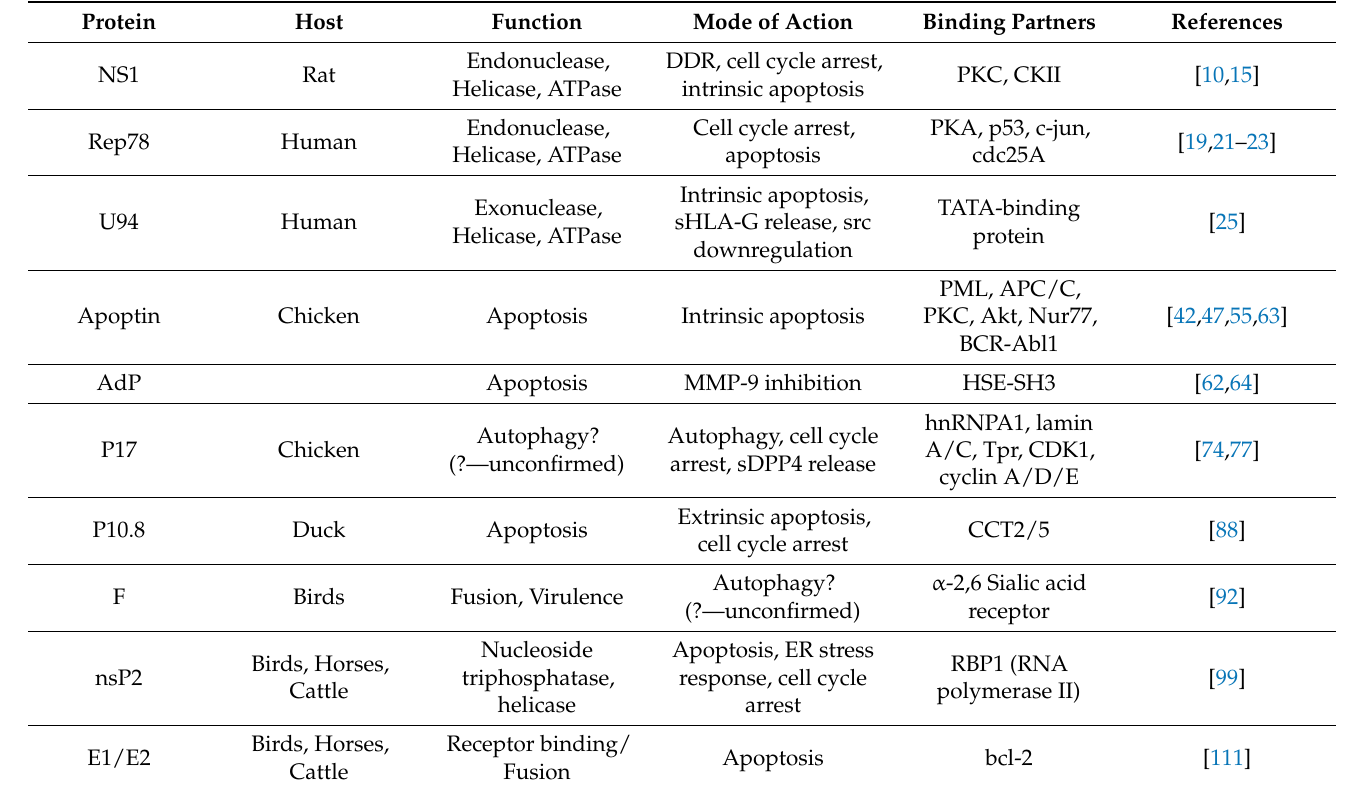
Table 1. Binding partners and their role in cancer growth suppression by viral